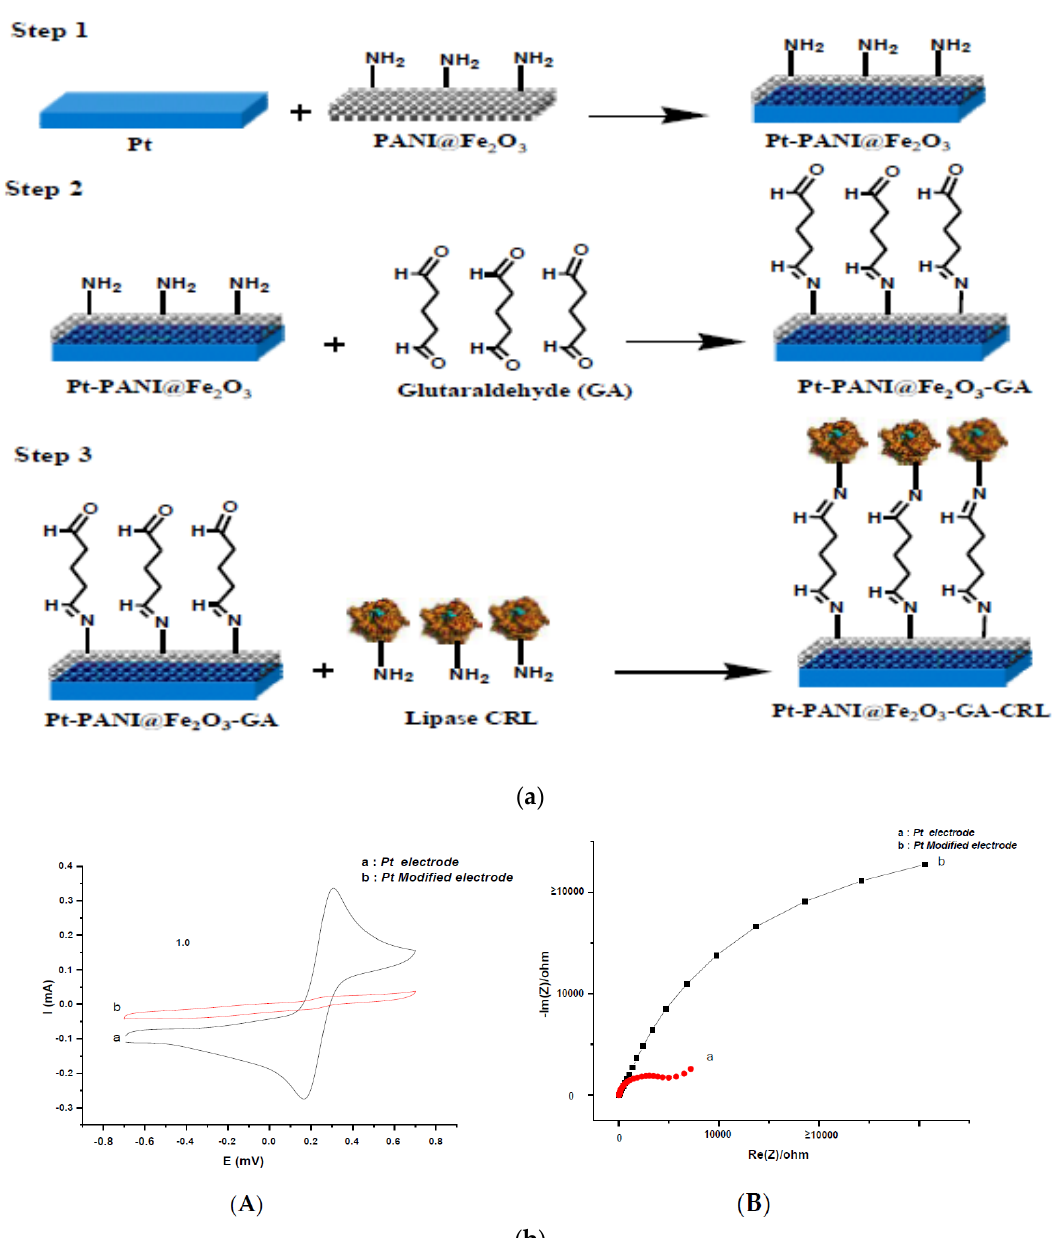
Figure 4. ( a ) Schematic representation of the biosensor elaboration using PANI@Fe 2 O 3 ; ( b ) Figure4. ( a )SchematicrepresentationofthebiosensorelaborationusingPANI@Fe 2 O 3 ; ( b )Voltammograms Voltammograms at 50 mV/s ( A ) and Diagram of Nyquist at − 200 mV potential of Pt bare electrode at 50 mV / s ( A ) and Diagram of Nyquist at − 200 mV potential of Pt bare electrode and Pt electrode modified and Pt electrode modified with an enzymatic membrane in 0.1 M phosphate buffered saline solution with an enzymatic membrane in 0.1 M phosphate buffered saline solution in the presence of Fe(CN 6 ) 3 − / 4 − . in the presence of Fe(CN 6 ) 3 − /4 − . (B) impedometry Reproduced with permission of [109], Copyright ( B ) impedometry Reproduced with permission of [109], Copyright 2018, 2018, MDPI.